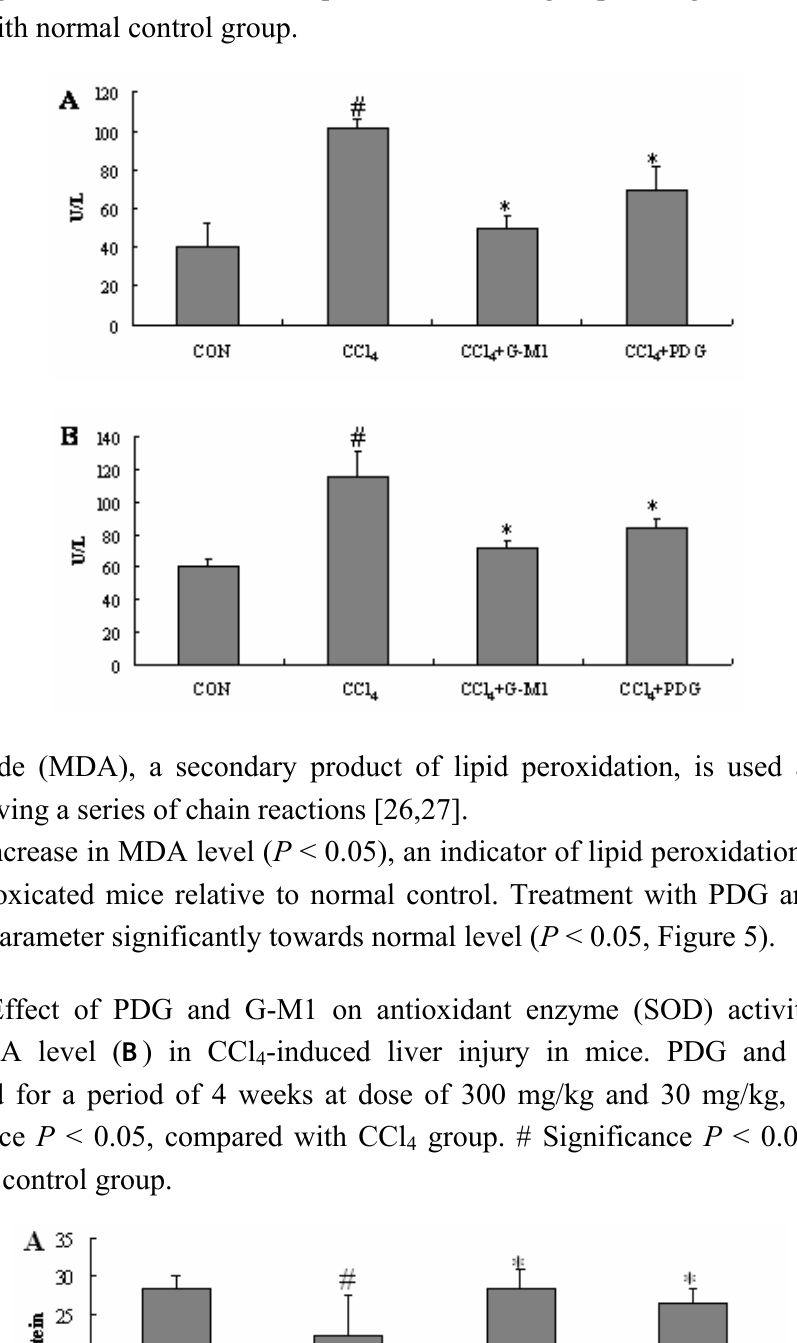
-induced liver 4 group. # Significance P < 0.05, 4